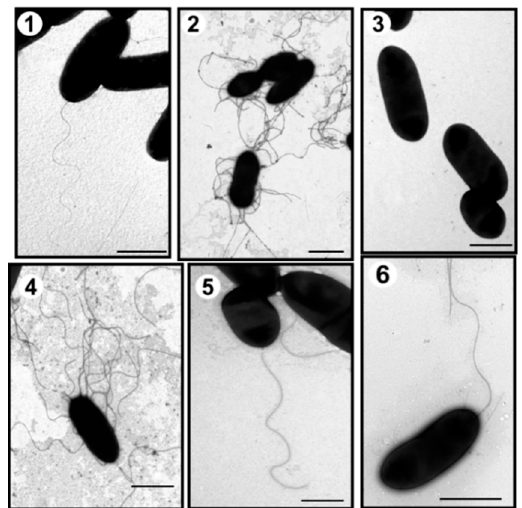
Figure 1. Transmission electron microscopy of A. hydrophila strains. AH-1 wild type grown in liquid media (TSB) ( 1 ) or in solid media (TSA) ( 2 ); AH-1 Δ pseI mutant grown in TSB ( 3 ) or in TSA ( 4 ); AH-1 Δ pseI mutant + pBAD- pseI grown in TSB ( 5 ), and AH-1 Δ rmlB mutant grown in TSB ( 6 ). Bar = 1 μ m.